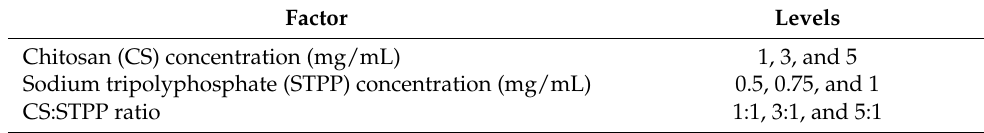
Table 1. The experimental design to produce the chitosan nanoparticles (CSNPs). Factor Levels Chitosan (CS) concentration (mg/mL) 1, 3, and 5 Sodium tripolyphosphate (STPP) concentration (mg/mL) 0.5, 0.75, and 1 CS:STPP ratio 1:1, 3:1, and